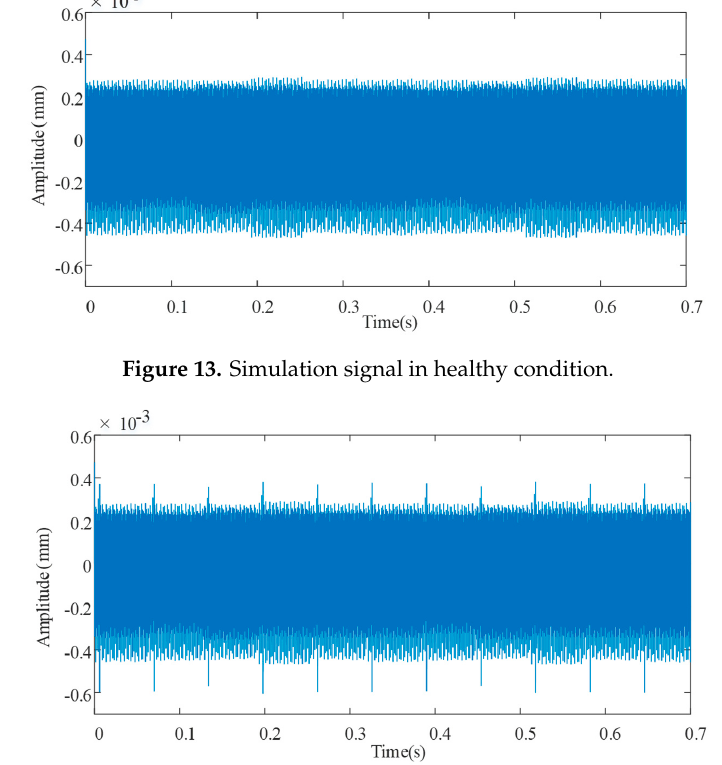
Figure 15. Simulation signal spectrum in healthy condition.